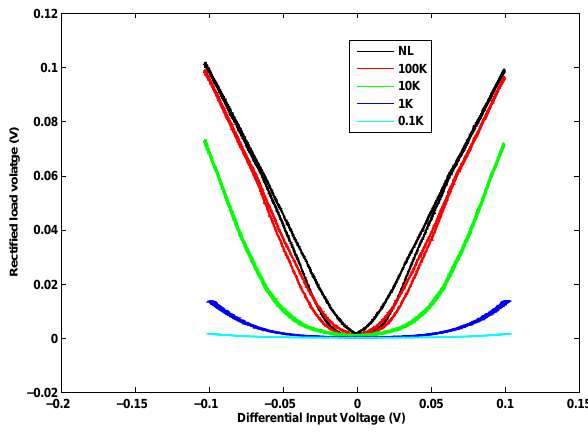
Figure 8: The rectifier input-output transfer char- acteristic for several ohmic